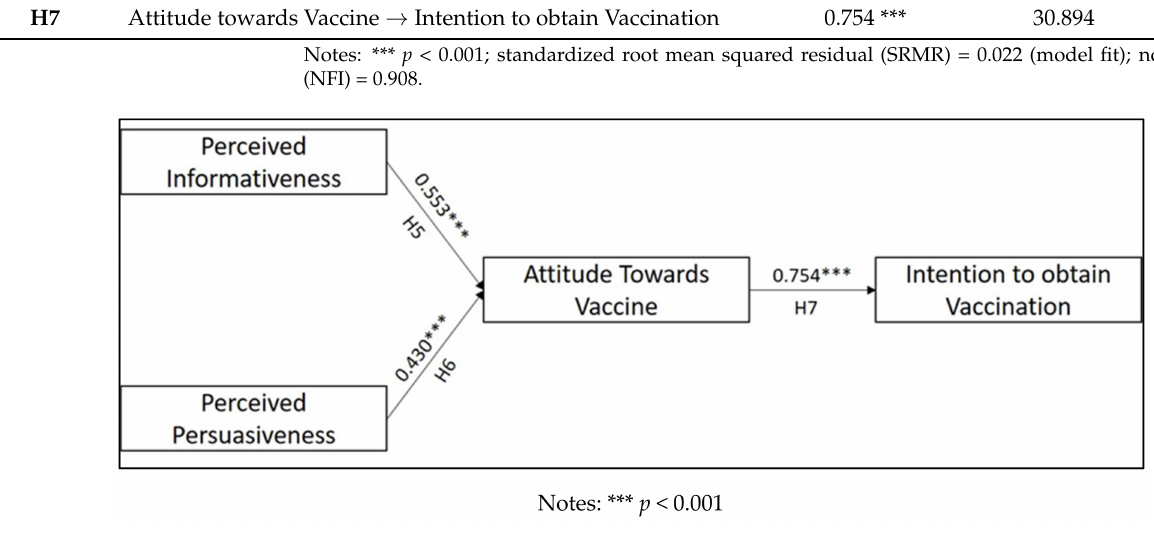
Figure 4. Path analysis of the